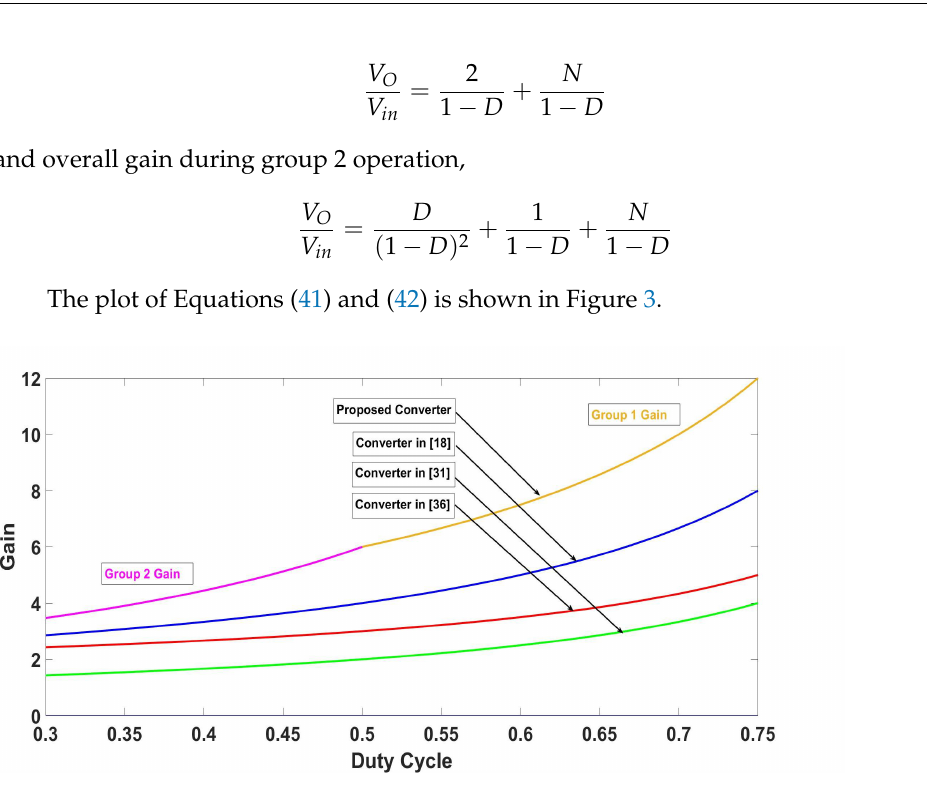
Figure 3. A comparison of gain vs. duty cycle.